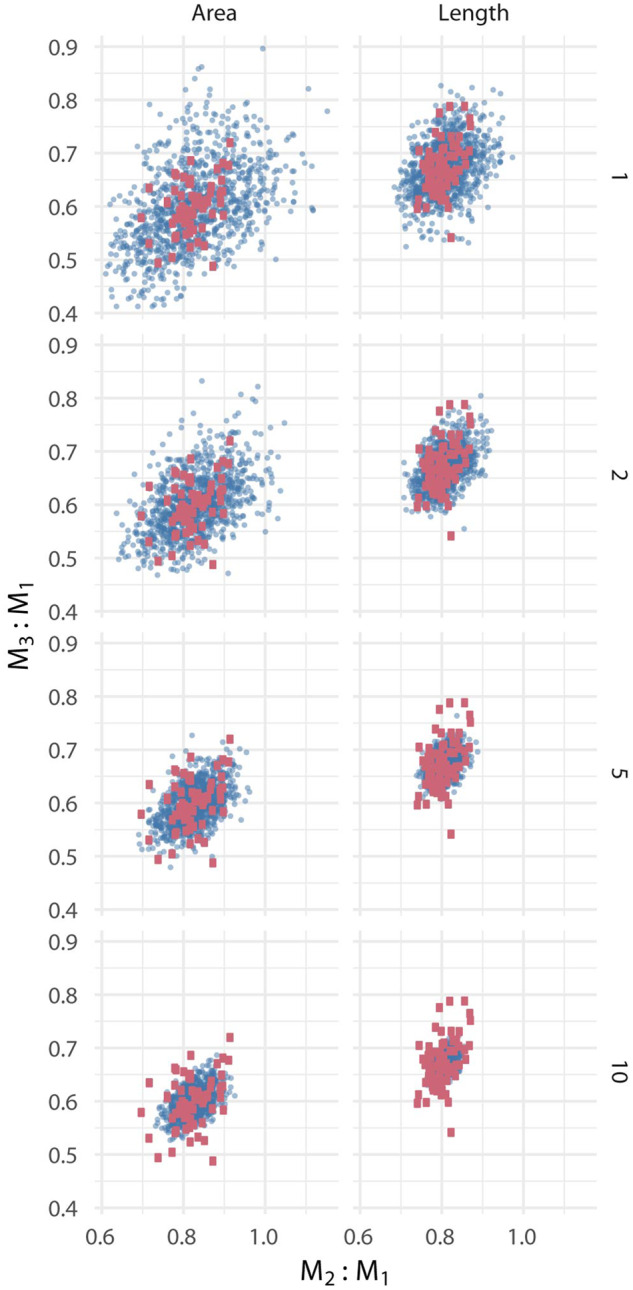
Comparison of occupation of ICM (area) or MMC (length) ratio morphospace by complete versus simulated molar rows derived from the same sample of P. gossypinus. Large red squares represent 70 complete molars rows. Small blue circles represent point estimates of ratios calculated by taking the mean of 1, 2, 5, or 10 isolated molars per tooth position per pseudosample.